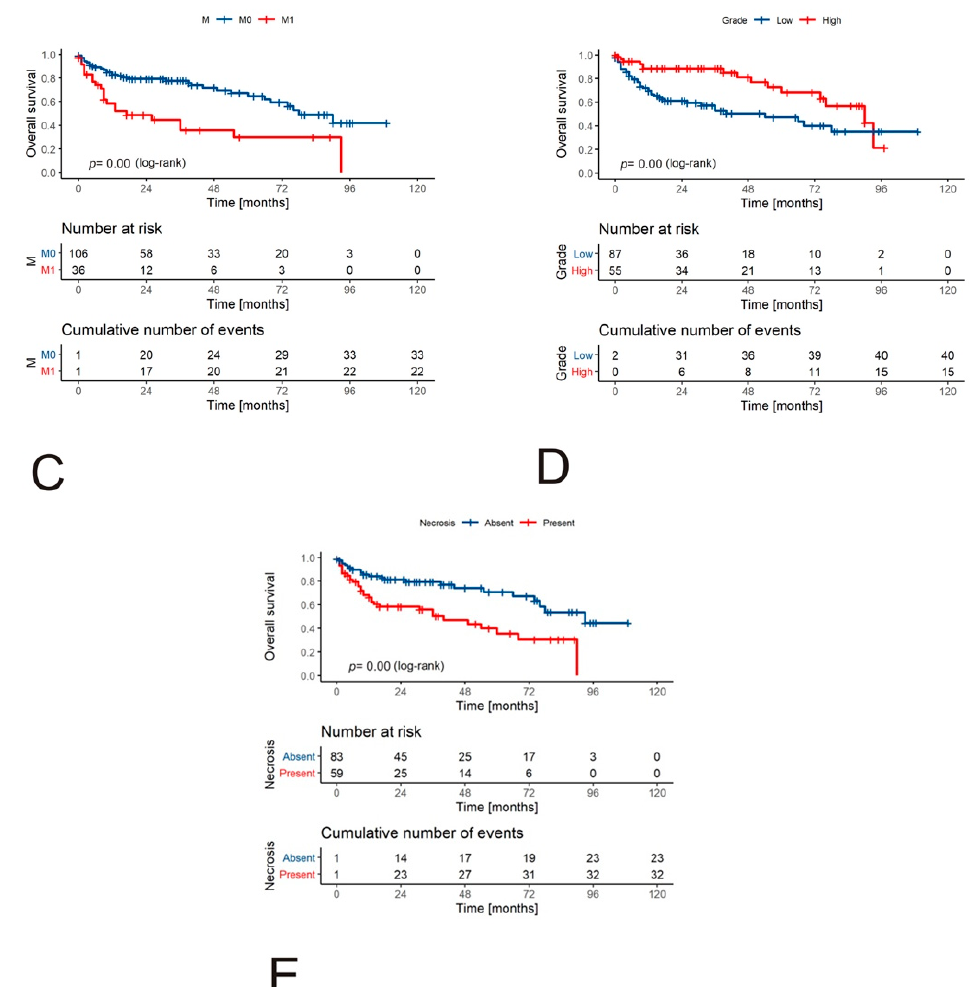
Figure 3. Survival of patients with RCC and tumor venous thrombus according to pathological variables. The Kaplan–Meier curves for OS are stratified by T descriptor (TNM 8th edition) ( A ), regional lymph nodes status; ( B ), the presence of distant metastases; ( C ), tumor grade; ( D ), and presence of necrosis within the tumor ( E ).